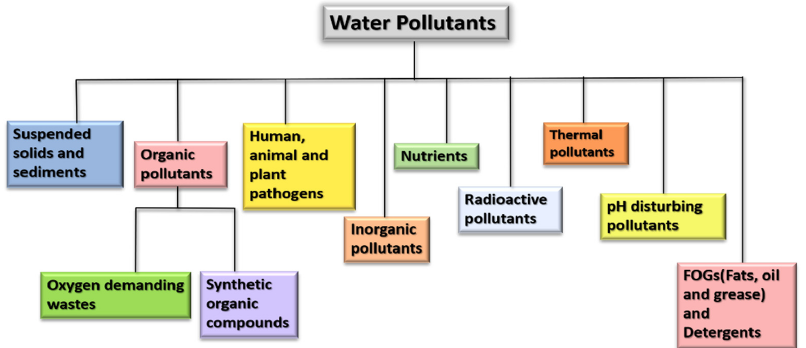
Figure 3. Flowchart representing various pollutants in wastewater.